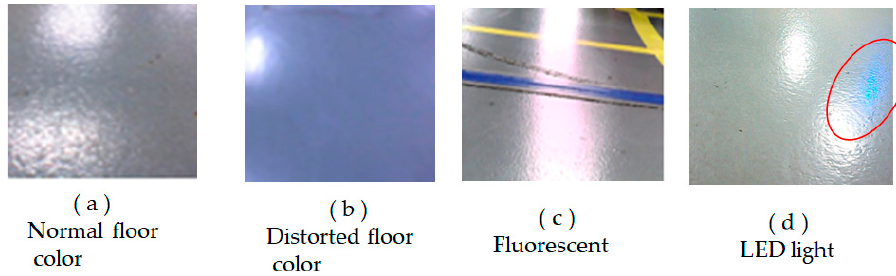
Figure 3. Distorted floor color. Figure 3a is a normal image of the floor, and the color of the floor in the picture is the same as the actual color. In Figure 3b, the floor in the image changes to a blue color. If we used a blue line as the vehicle guidance line, this may cause misjudgments. Figure 3c shows light interference caused by fluorescent lights. The yellow line becomes very bright due to the interference, and it cannot be correctly identified as a yellow line. In Figure 3d, the image is disturbed by the LED light of the instrument projected onto the floor. The color distortion causes great problems when it comes to image recognition. Using RGB color model recognition technology, we often cannot identify the floor or the guidance line accurately. Therefore, we used hue–saturation–intensity (HSI) color model technol- ogy [34]. HSI color model technology uses three components to represent color. The value of hue is between − 180 and 180, the value of saturation is between 0 and 1, and the value of intensity is between 0 and 255, and this provides better distinctions between pixel colors [35–37]. In order to adapt to different factory environments, we designed a self-learning mechanism to analyze the required line color and obtain the parameters required by the system. This eliminates the need for manually testing the photos one by one and recording the hue–saturation–intensity value, reducing the required manpower and shortening the test time. Applying AI’s powerful machine learning (ML) [38,39] capabilities to hardware devices enables devices to perform analytics flexibly. ML can usually learn from past data and experiences to find the rules of its operation. In this case, ML involves color pattern training to recognize patterns using examples rather than programming with specific rules. It takes samples from the database to learn and create a hue–saturation–intensity rule for a set of colors and use it to make predictions. We use a full-color template image for the system to compare with the floor image, enabling the system to learn and record the values of the colors. The system automatically distinguishes colors and records related parameters, as shown in Figure 4. Figure 4. Machine learning analysis. The two yellow blocks in the red circle in Figure 3a are similar in color. The left yellow block in the red circle is from the full-color template, and the right one is from a picture of the yellow line on the floor. The HSI values of the template are: hue (0.17), saturation